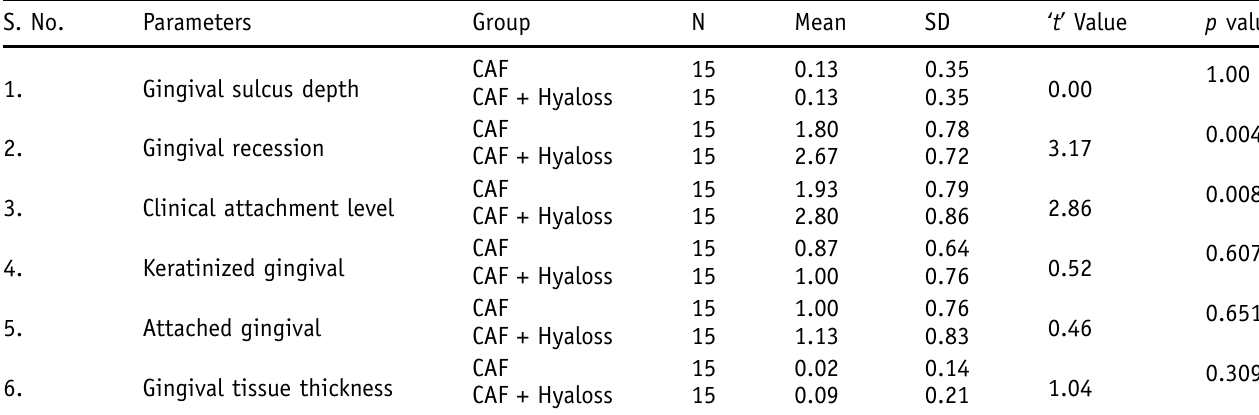
Table IV. Shows intergroup comparison of parameters at 90 days after surgery for both control (CAF) and test (CAF + Hyaloss)